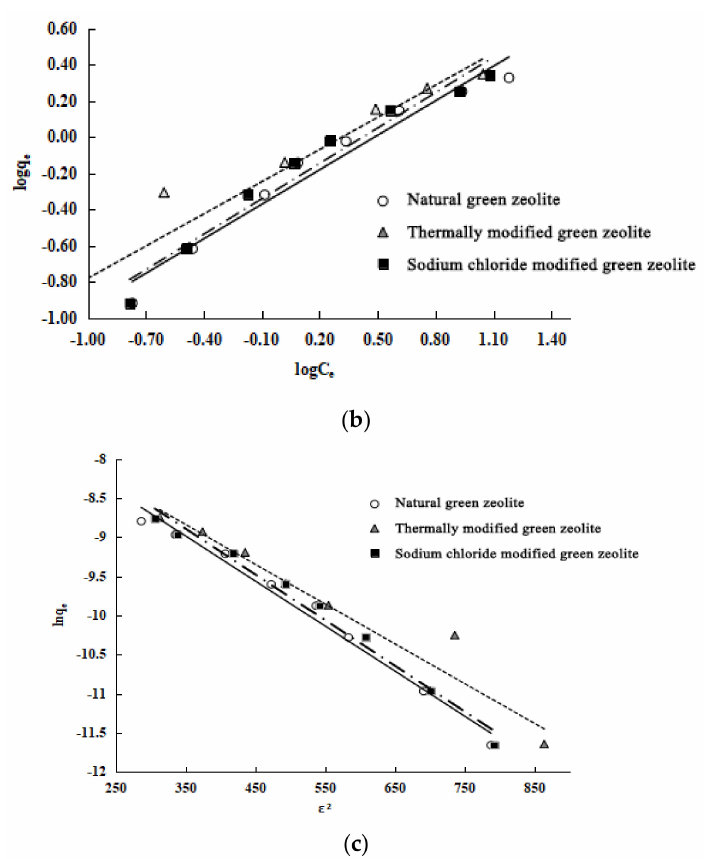
Figure 8. Isotherm adsorption model of three kind of zeolites onto nitrogen: ( a ) Langmuir model, ( b ) Freundlich model and ( c ) Dubinin–Radushkevich (D–R) model. Solid lines represent natural, dotted lines represent thermally modified and dashed lines represent NaCl modified green